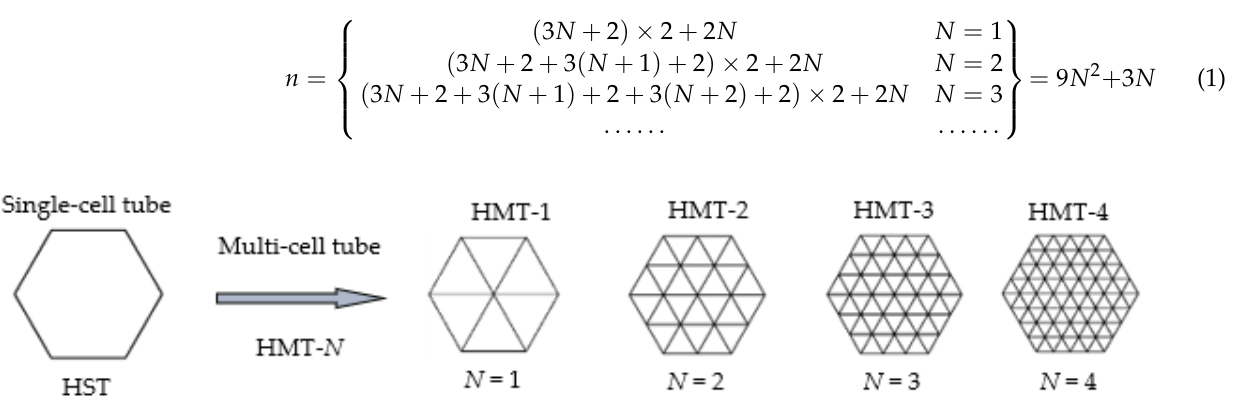
Figure 1. Topology of HMTs with different side segments. Table 1. Dimensions of designed hexagonal thin-walled tubes.